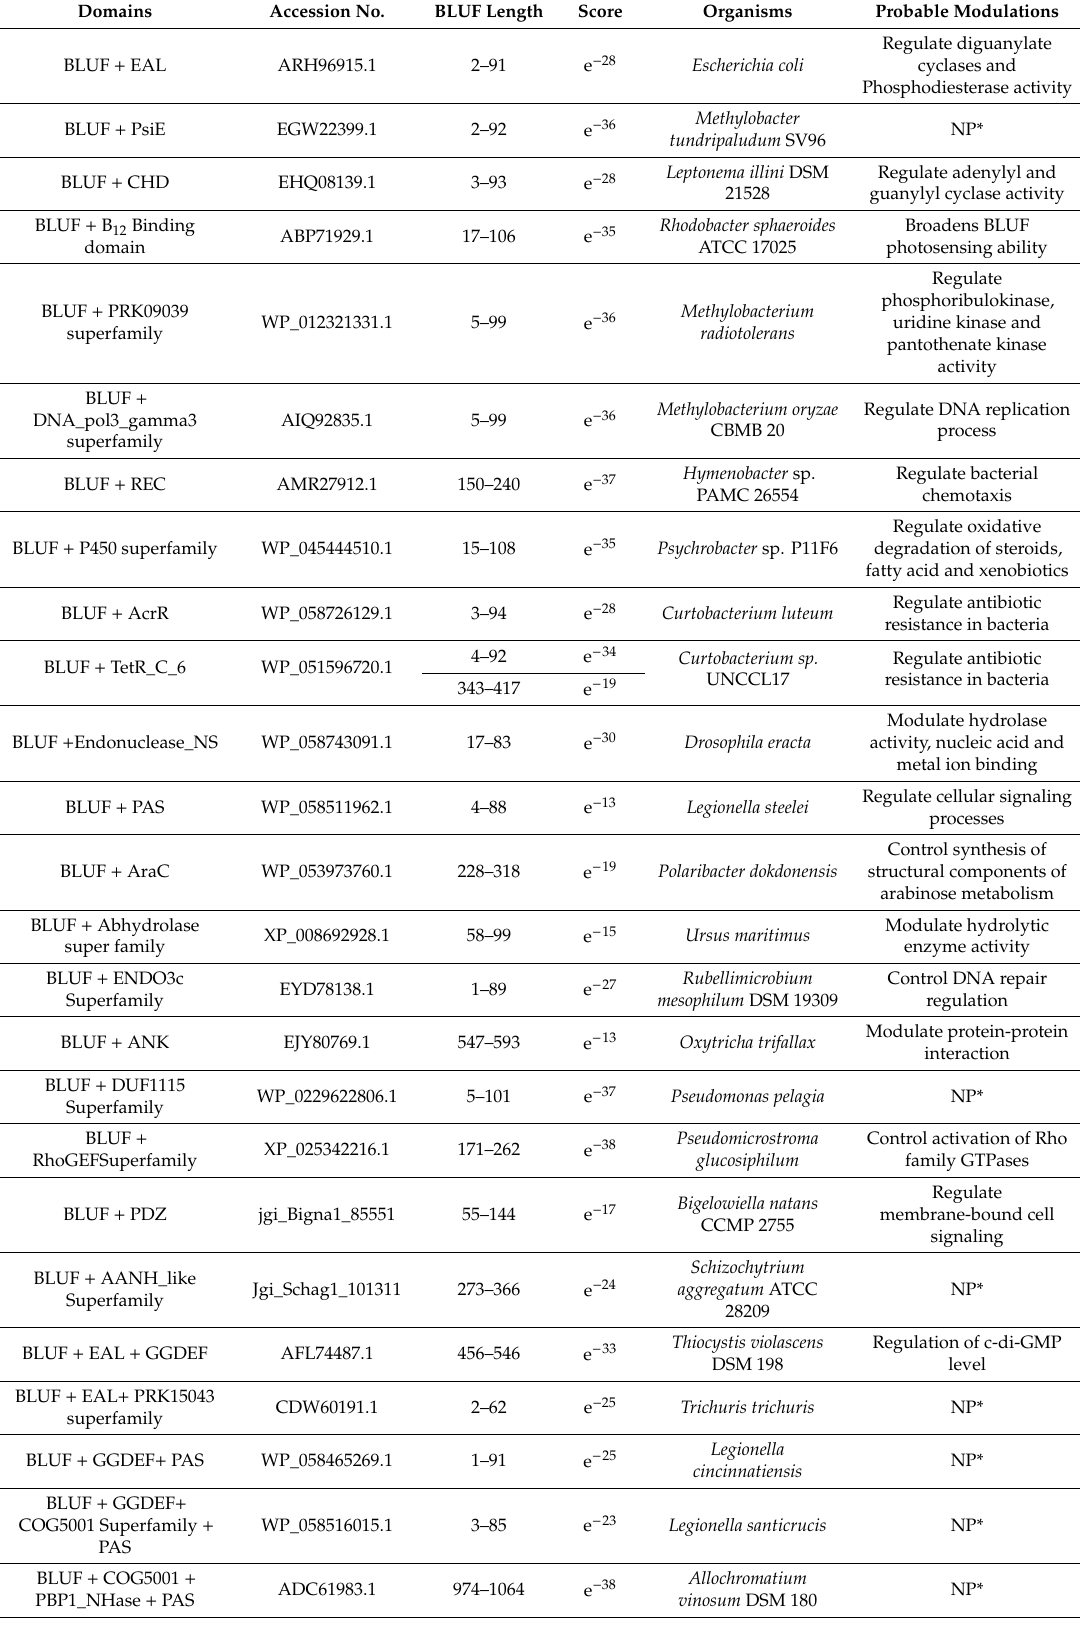
Table 1. Blue light using flavin (BLUF) modular domains from di ff erent